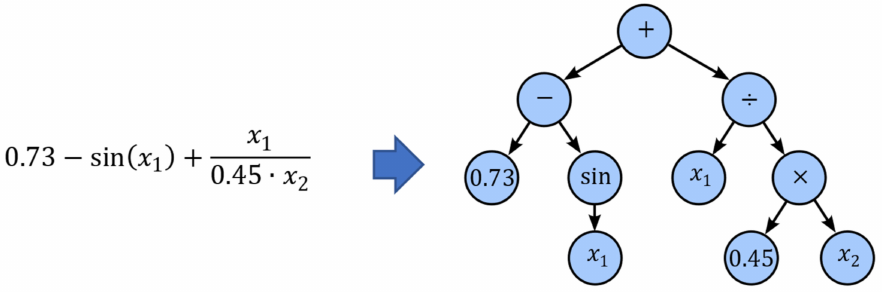
Figure 9. Representation of a function as an expression